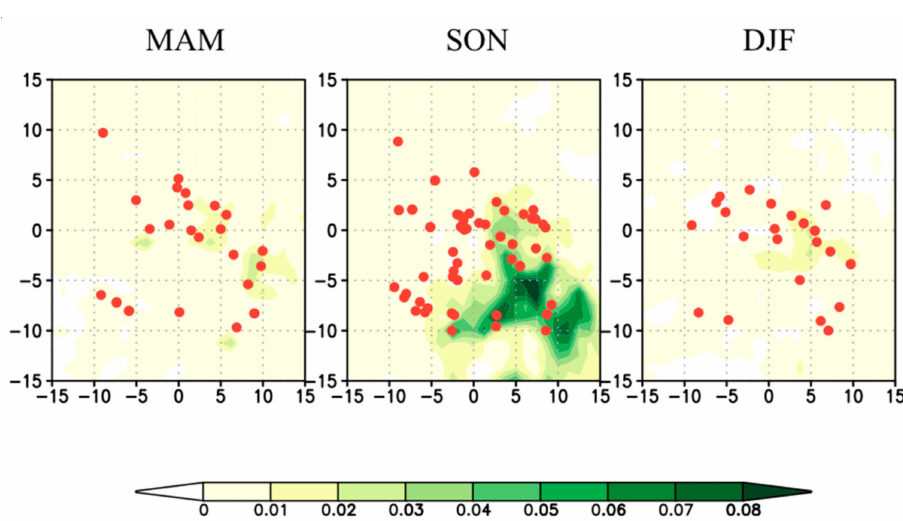
Figure 5. Cyclone relative composite: energy helicity index ( EHI ) (colors) in ( left ) spring, ( middle ) autumn, and ( right ) winter. Cyclone-relative tornado locations are shown with red